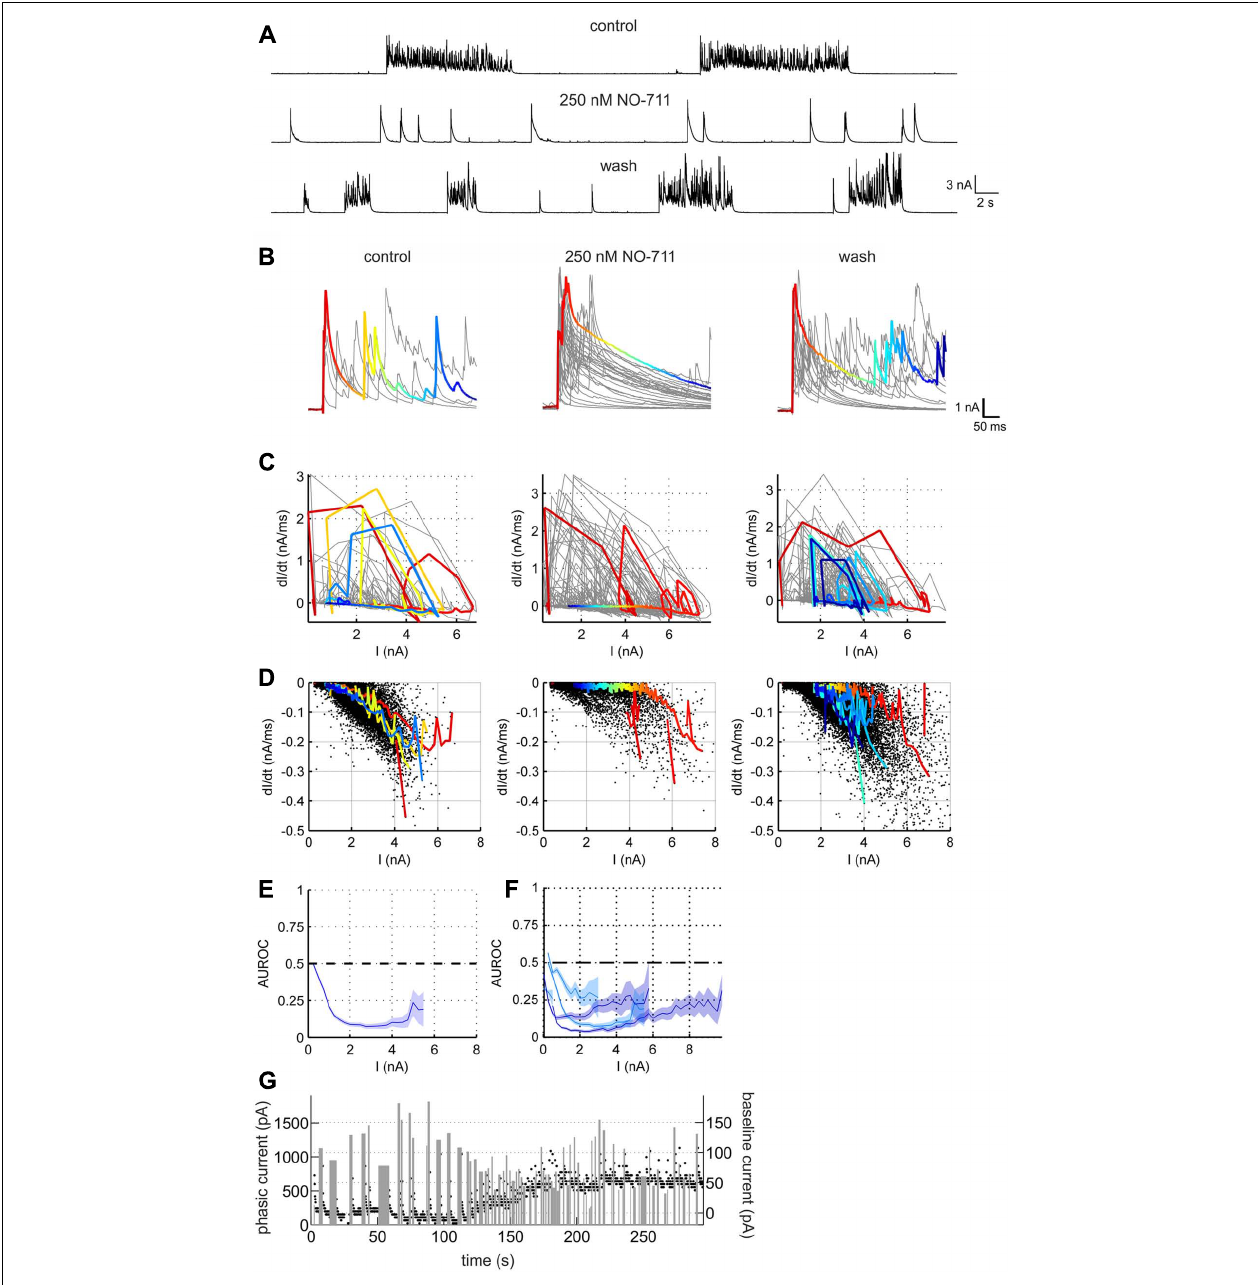
FIGURE 5 | GABAergic currents altered by GAT-1 inhibition. (A) Example recording of a putative pyramidal neuron held in voltage clamp at 0 mV, revealing large outward currents which reflect mostly chloride currents through GABA A receptors.The effects of NO-711 were only partly reversible after washout. (B) Excerpts of outward currents triggered to the onset of the bursts. In all three conditions, one representative burst is depicted in color, the hue corresponding to time. (C) Plots of current slope vs. current amplitude for the excerpts shown in (B) (same column order). Colored trajectories correspond to the colored excerpts in (B) . Jagged appearance of positive slopes (rise phase) is due to downsampling of data to 1000 Hz (after lowpass filtering at 500 Hz). (D) Plots of current slope vs. current amplitude for all excerpts at full length in the recording shown in (A) , restricted to the decay phases (negative slopes). Each dot represents one linear slope. Colored trajectories are the same as in (C) , except that segments with a